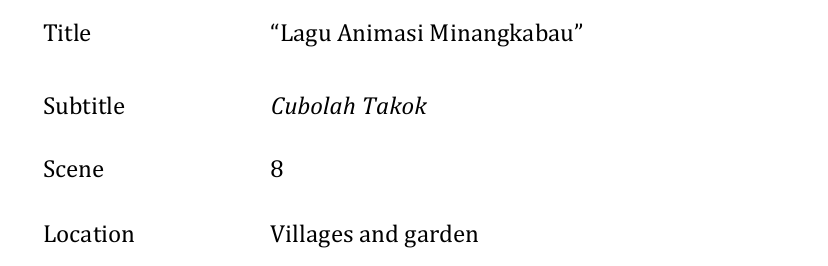
Table 2 Application of Minangkabau Song Animation media for